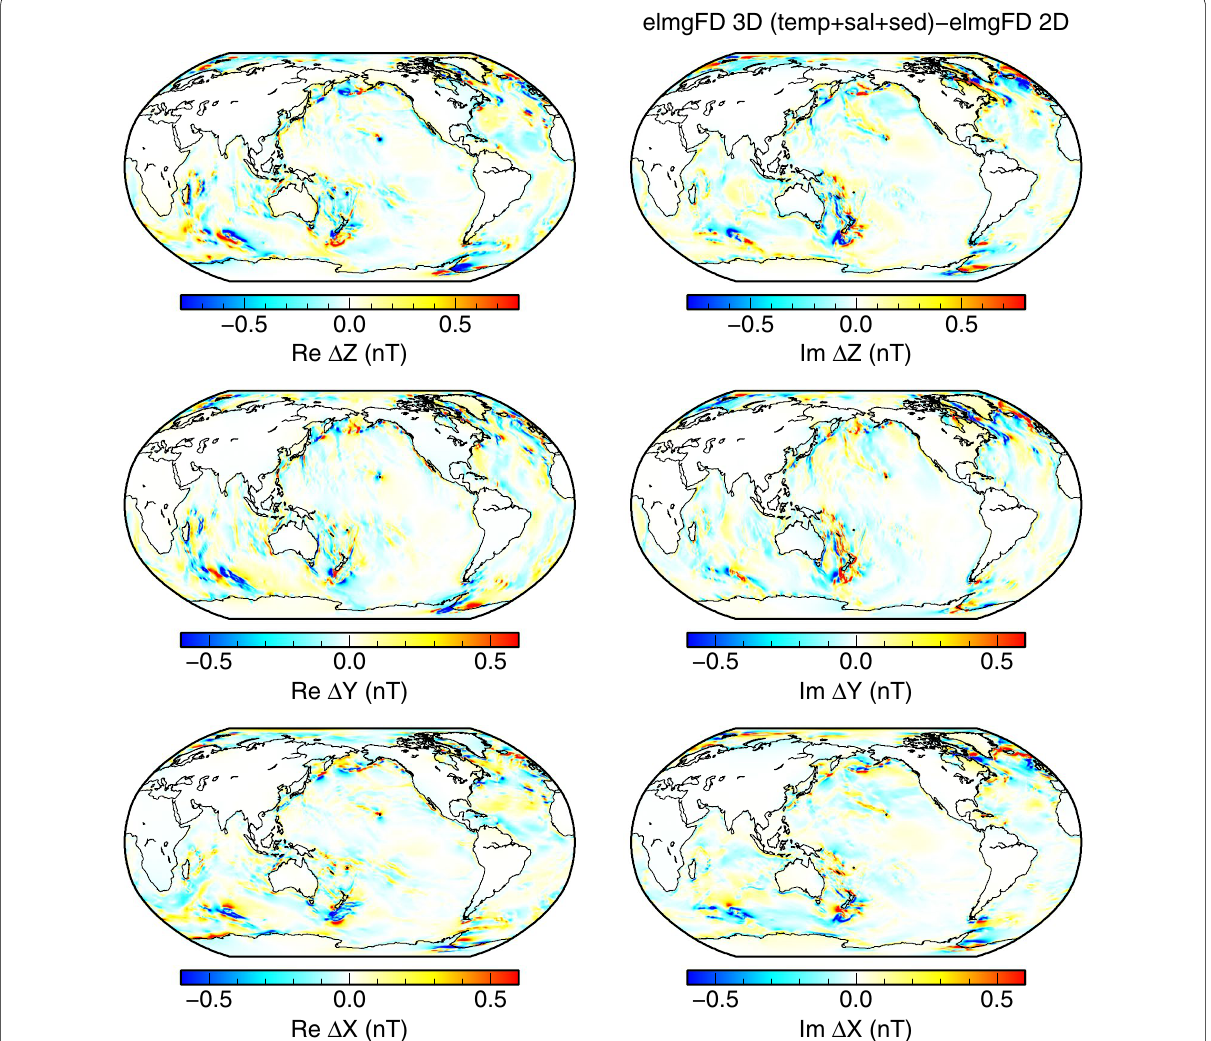
Fig. 7 Effect of variable seawater conductivity and sediments. Differences between the 3-D and 2-D solutions calculated at the Earth’s surface with the elmgFD code at j max = 480 . The 3-D solution includes temperature and salinity-dependent seawater conductivity and variable sediment thickness and discretizes the ocean with 102